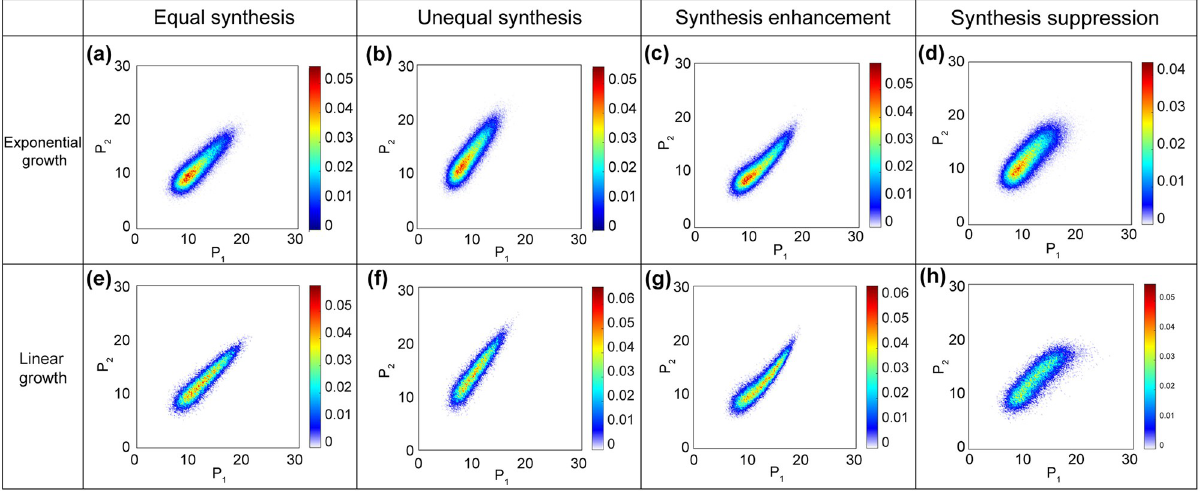
Fig 8. Computed proteome distributions (yeast parameters) in exponential growth and linear growth. Mammalian cell models show a similar behavior. (a) equal synthesis of P 1 and P 2 without gene regulation. The two proteins are naturally correlated because of growth through cell cycle. (b) unequal synthesis without correlation. (c) one protein enhances the synthesis of the other. (d) one protein suppresses the synthesis of the other. The distribution is not linearly correlated for synthesis enhancement and suppression cases. (e)-(h) Corresponding results for linear growth. All parameters except synthesis parameters are listed in Table 2. In the linear growth case, transport coefficient is set to be: � t